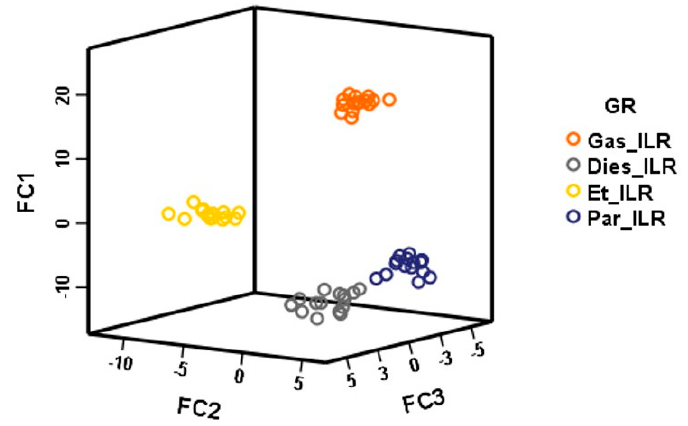
Figure 4. Discriminant scores obtained from LDA for burned samples (D 64 × 428 ).